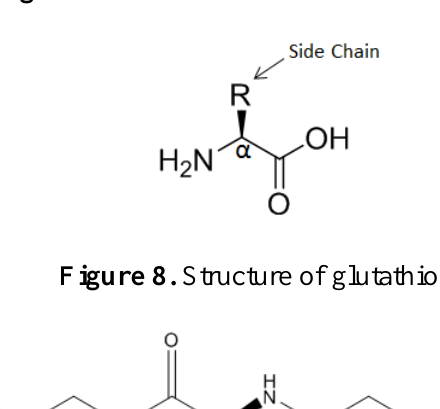
Figure 7. General structure of α-amino acids.